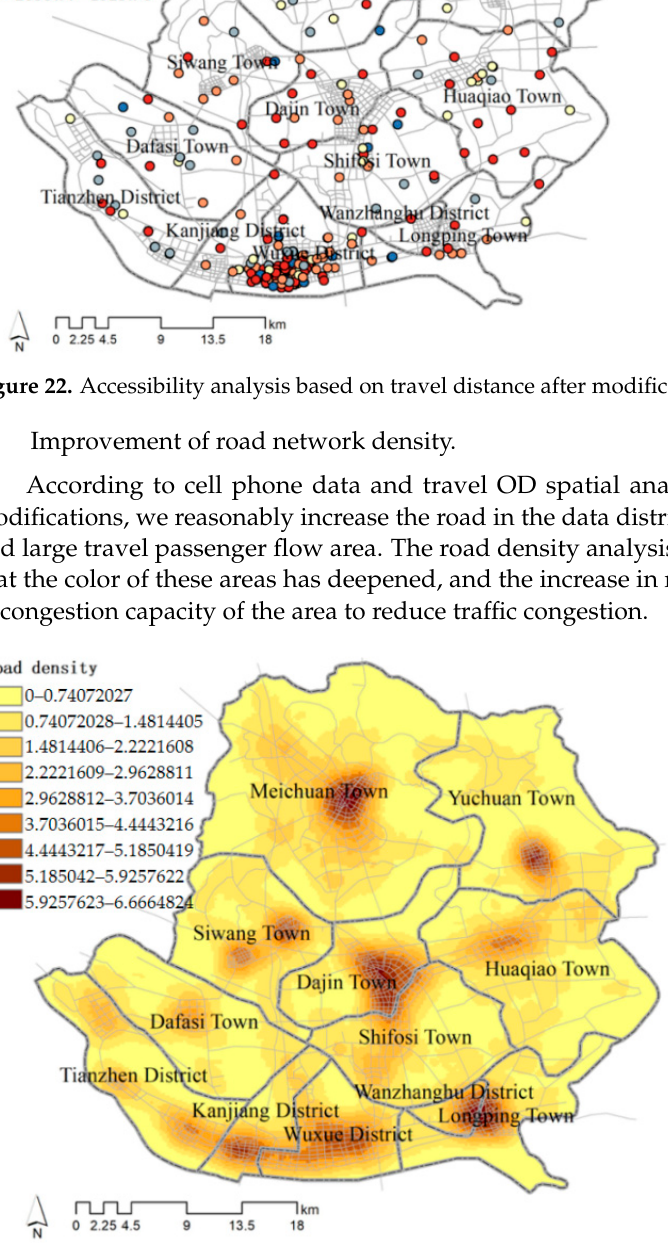
Figure 23. Analysis of road network density after modification.